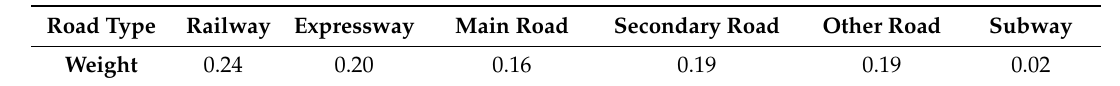
Table 1. The weights of di ff erent